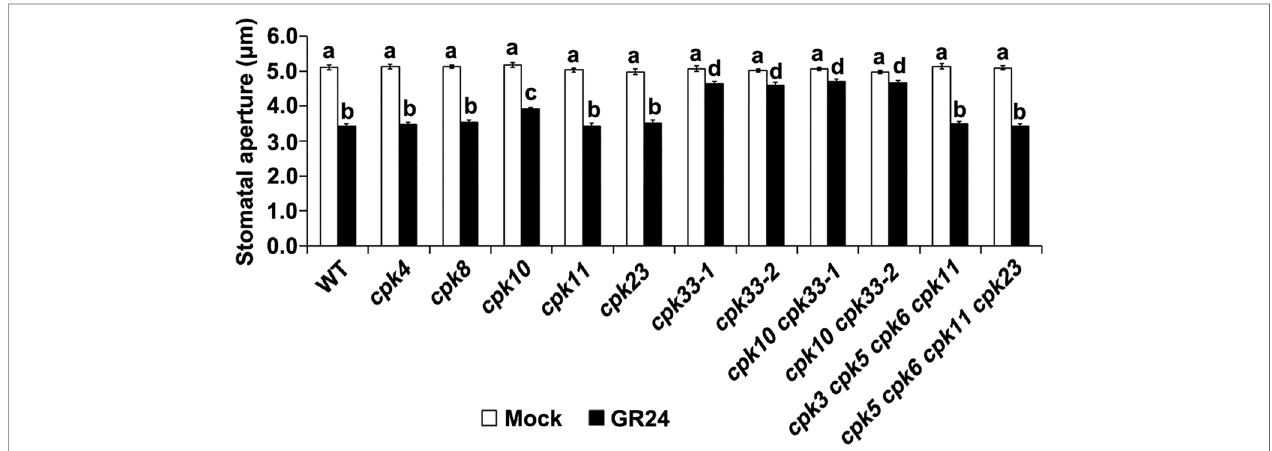
FIGURE 2 | Strigolactone-stimulated stomatal closure is mediated by CPK33. Leaf epidermal peels of WT plants and a collection of cpk mutants were exposed to the MES-KCl buffer in the absence and presence of 1 m M GR24. Stomatal apertures were measured and presented as means ± SE of three independent experiments. Bars with different letters represent statistically signi fi cant